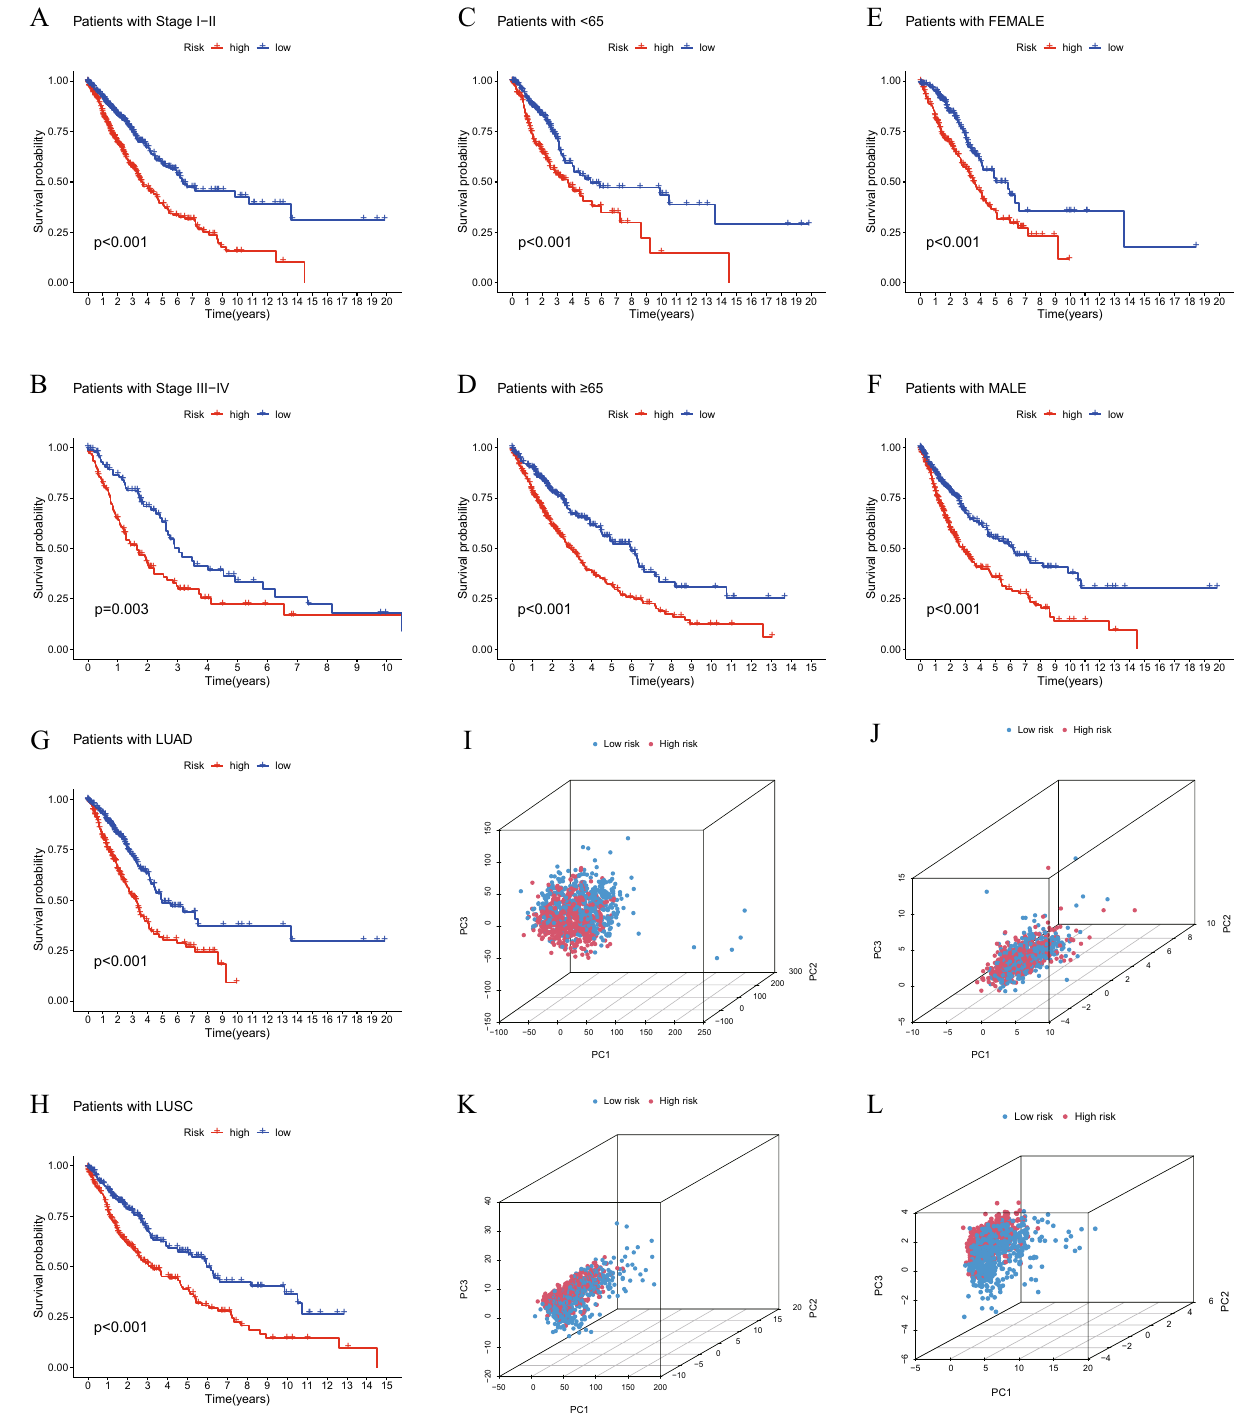
Figure 6. K-M survival curves of patients. Stage I-II ( A ), stage III-IV ( B ), age < 65 years ( C ), age ≥ 65 years ( D ), female ( E ) and male ( F ), LUAD ( G ) and LUSC ( H ). PCA diagrams according to the expression of all genes ( I ), cuproptosis-related genes ( J ), cuproptosis-related lncRNAs ( K ) and 8 signature lncRNAs ( L ). K-M, Kaplan– Meier; lncRNA, long non-coding RNA; PCA, principal component